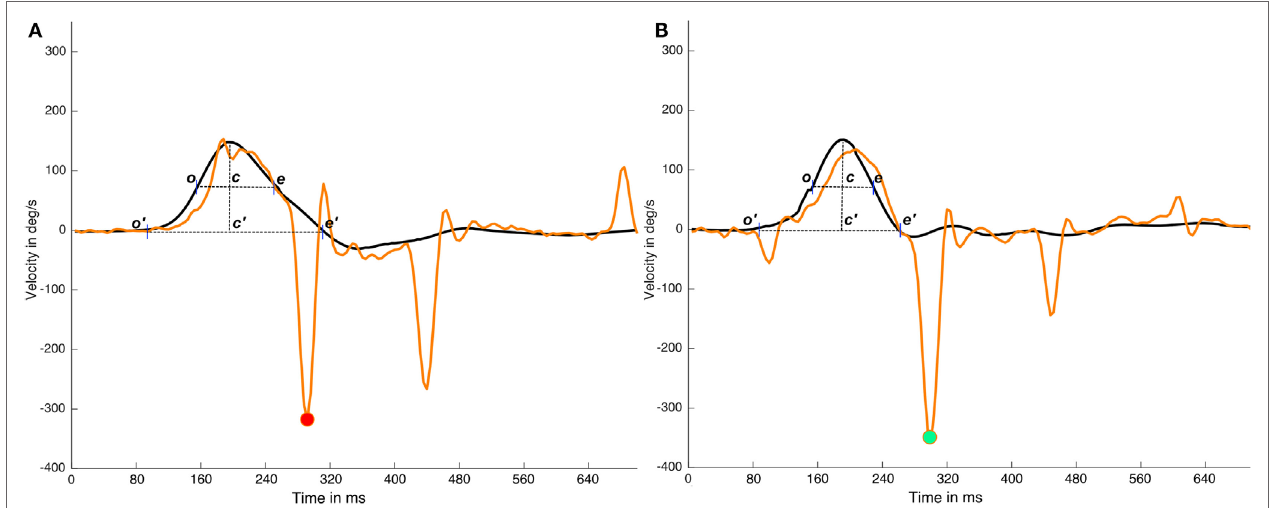
FigUre 3 | Effects of head impulse asymmetries on time period calculations. In this figure, two impulses (real data) from the same video head impulse test (vHIT) test are plotted; in the (a) impulse it is plotted an impulse with a very large and asymmetric head impulse (c ′ e ′ > o ′ c ′ ) with a cross point on x -axis (e ′ ) that occurs at ~80 samples time, in (B) impulse it is plotted an impulse with a more symmetric head impulse (c ′ e ′ ≈ o ′ c ′ ). (a) and (B) has a first saccadic response at the same time moment ~70 samples. If we consider the c ′ e ′ time interval, determined by the cross to 0°/sec point (e ′ ) to calculate the early response period, the same saccadic response is classified as early on (a) impulse and as not early on (B) impulse. But if the width of the head impulse (ce segment in plots) is used to calculate the early response period, because it is less affected by the head impulse asymmetry, the first saccade will be recognized as not-early on both (a) and (B) impulses. Black lines are head impulses, orange lines are eye responses, magenta point is marking the (wrong) early eye saccade on the (a) impulse and green point is marking the not early saccade in the (B)